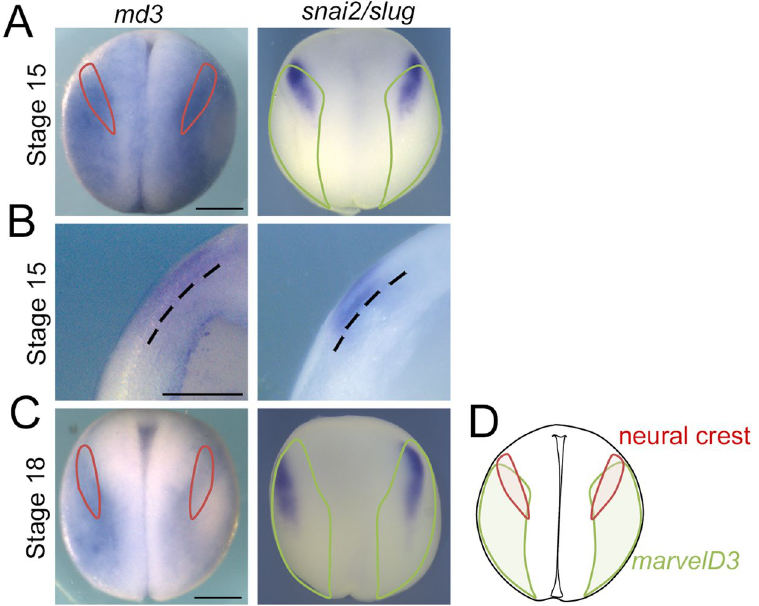
Figure 3. marveld3 transcript expression domain at neurula stage. Dorsal view of stage 15 ( A ) and 18 ( C ) whole embryos analysed for marveld3 and snai2/slug expression by Whole-mount in situ hybridization (WISH). ( B ) WISH analysis of marveld3 and snai2/slug expression on transversal sections of bisected embryos at stage 15. ( D ) Scheme representing the expression domains of marveld3 (green) and neural crest